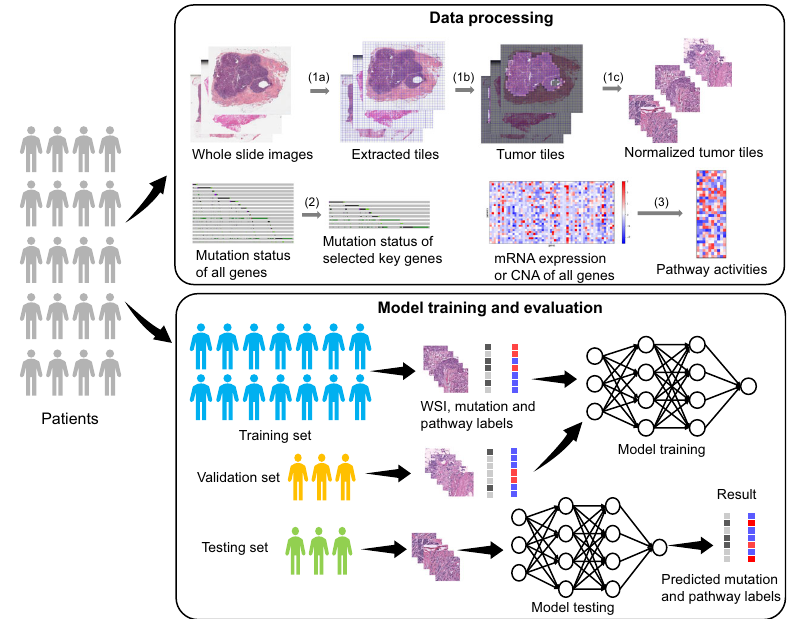
Fig. 7 Illustration of the deep-learning work fl ow for data processing and model evaluation. We processed the WSI data by extracting tiles (1a), identifying tumor titles (1b), and generating small nonoverlapping tiles with color normalization. We selected key mutational genes (2) and identi fi ed biological pathways from mRNA (or CNA) expressions (3). Model training was based on a pretrained ResNet-101 model with an attention mechanism. After model selection, the trained model was used to test tiles and assess their prediction